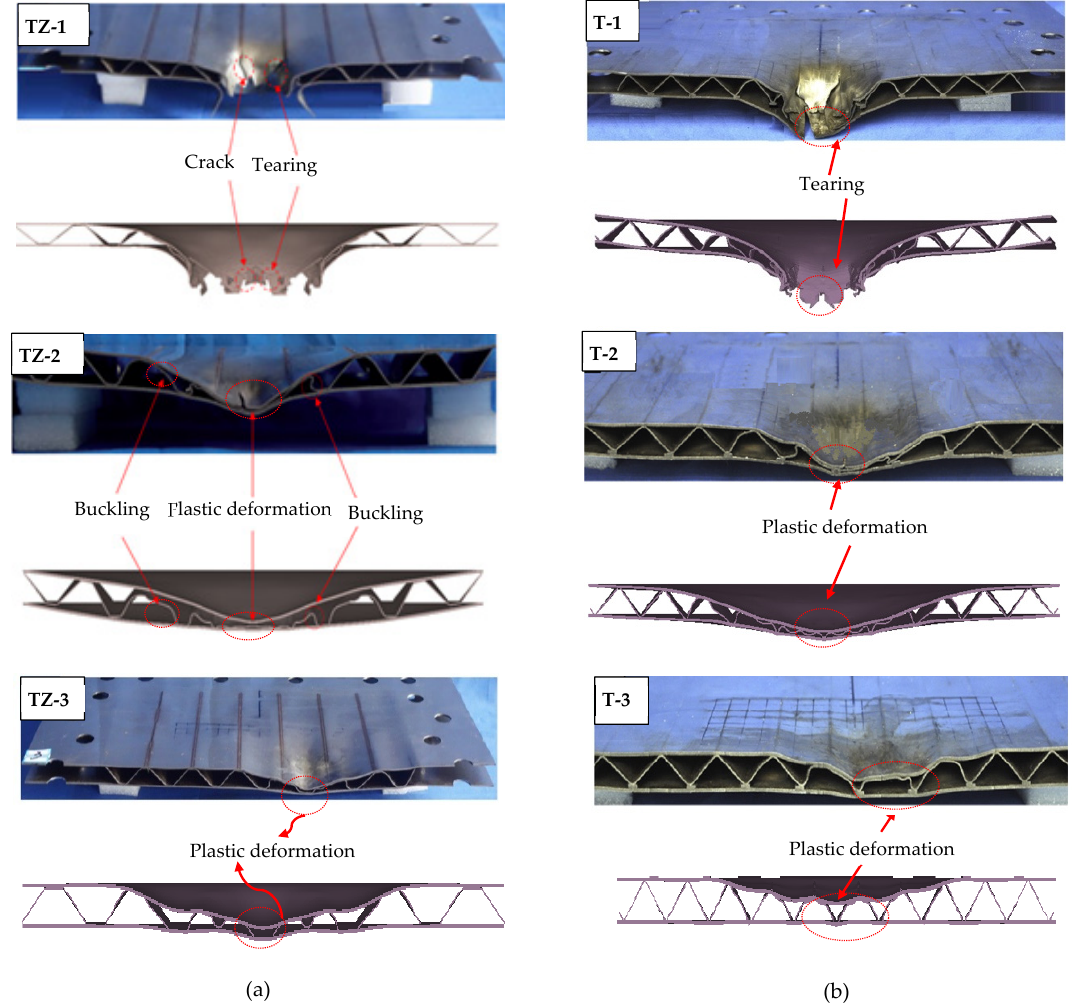
Figure 4. Comparison between the experimental and numerical results of deformation/failure modes due to detonation at stand-off distances ( SoD s) of 50, 100, and 150 mm. ( a ) TZ-panel. ( b ) T-panel. Table 5. Experimental and numerical results.